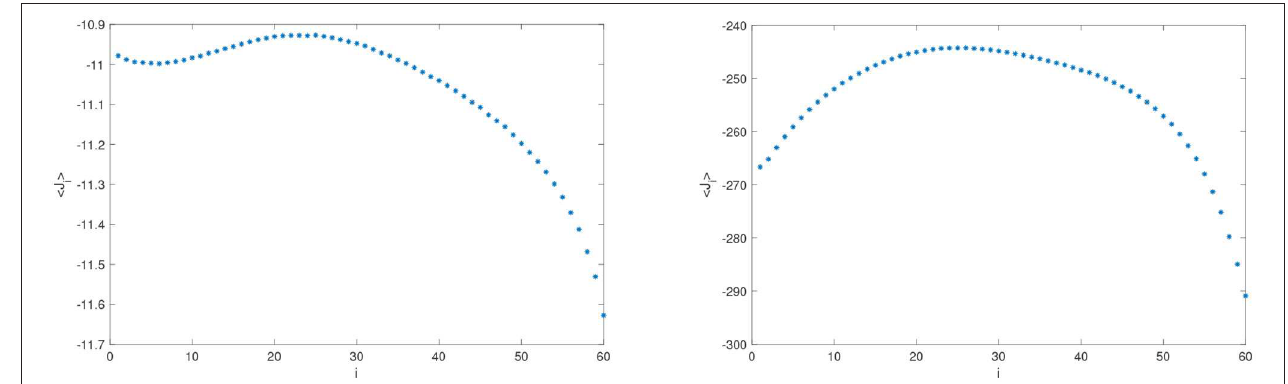
J i computed according to Equation (11), for N h i